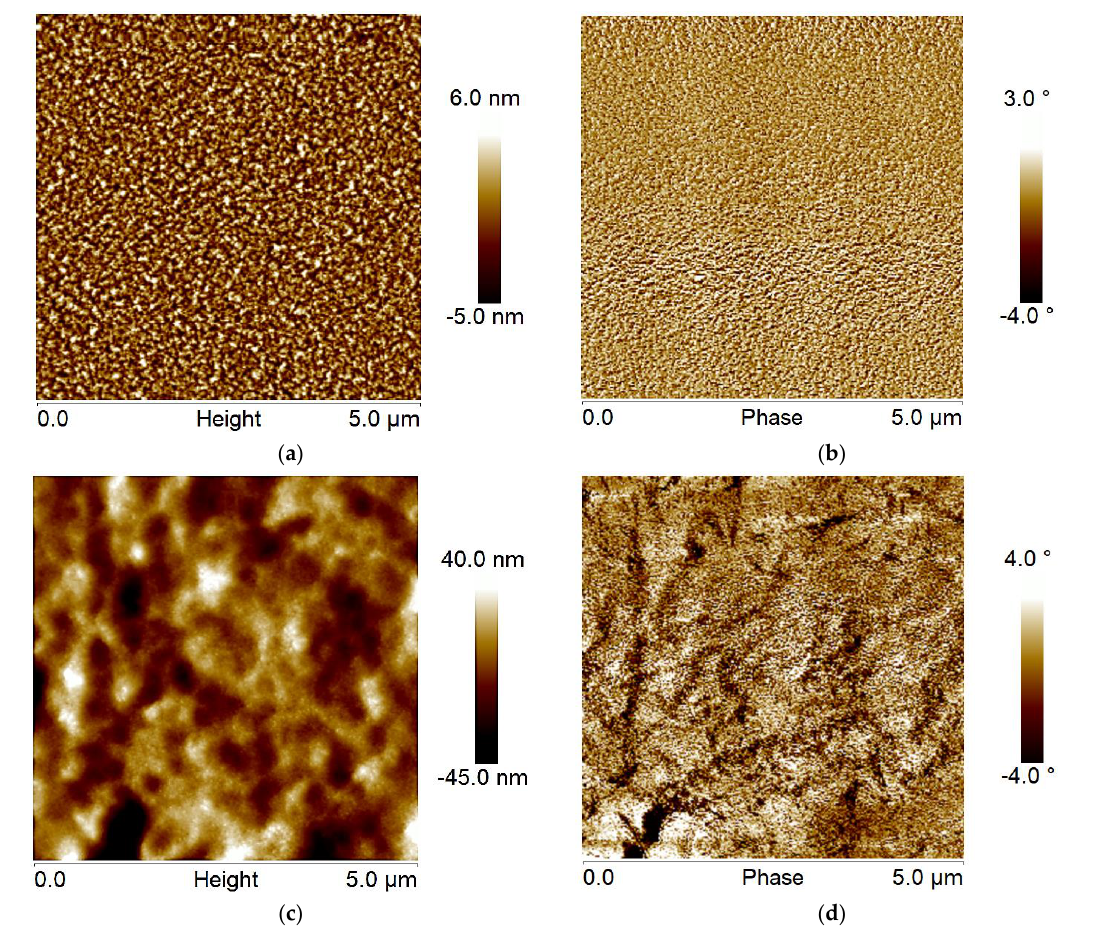
Figure 5. AFM topography ( a , c ) and phase ( b , d ) images of P3HT layer on SiO 2 ( a , b ) and GO ( c , d ) surfaces, where the GO was deposited onto the SiO 2 layer.